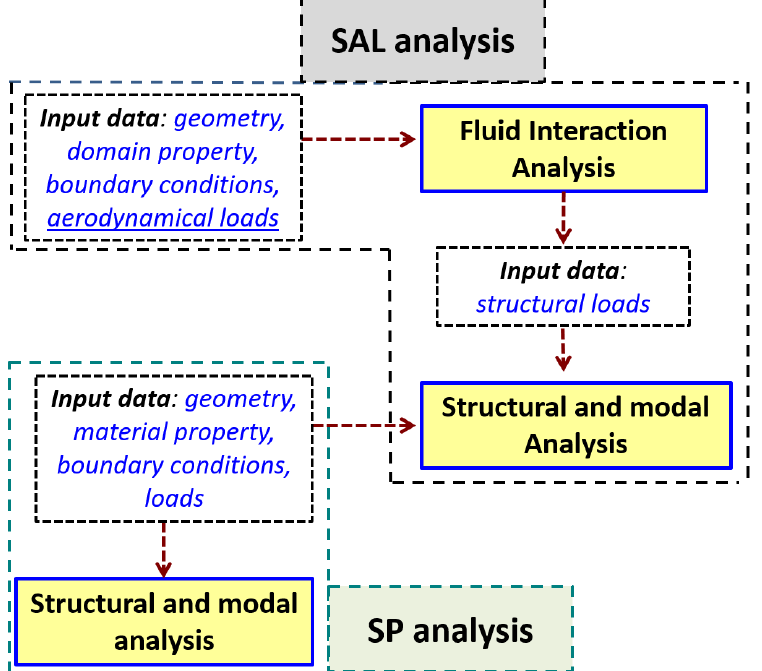
Figure 2. Structure of the SP (with no aerodynamic loads consideration) and SAL analysis Fluid Structure